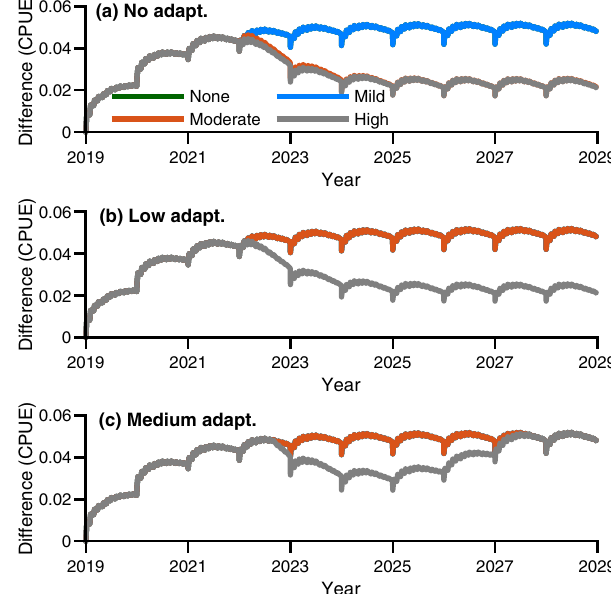
Fig. 5 Adaptive capacity vs median improvement in coral cover due to manual control. The median impact that monthly manual control makes across all sub-reef management sites expressed in terms of the difference in coral cover (%) between control and no control over a 10-year projected period. Different line colours correspond to different modelled levels of accumulated thermal stress experienced by corals. The green curve corresponded to no stress (Degree Heating Weeks (DHW) ¼ 0), the blue curve corresponded to mild stress (DHW = 4), the orange curve corresponded to moderate stress, (DHW = 7) and the grey curve corresponded to high accumulated thermal stress (DHW = 10). Figure panels vary in terms of modelled coral adaptive and acclimation capacity. a no adaptive and acclimation capacity ( A ¼ 0). b low adaptive and acclimation capacity ( A ¼ 2 : 5). c medium adaptive and acclimation capacity ( A ¼ 5). Increasing adaptive and acclimation capacity improved management-derived improvements in coral cover across higher levels of thermal stress. Mean was of similar dynamics, but attained higher values. Source data (model outputs) provided.